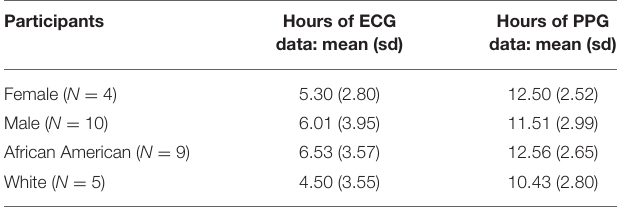
TABLE 5 | Data yield for PPG and ECG sensors by gender and race.